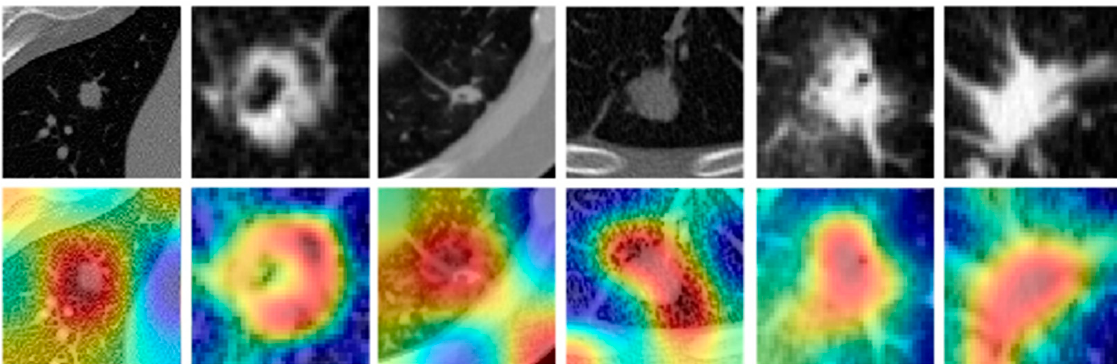
Figure 8. Six pulmonary nodules and the corresponding activation maps generated by CNN. CNN’s attention maps ( bottom row ) shows that the deep learning model relies not only on the nodule surface but also on the immediate periphery region to discriminate nodules. The model learns from the nodule periphery especially in the consolidated nodules ( panels 1 , 3 , 4 from left).